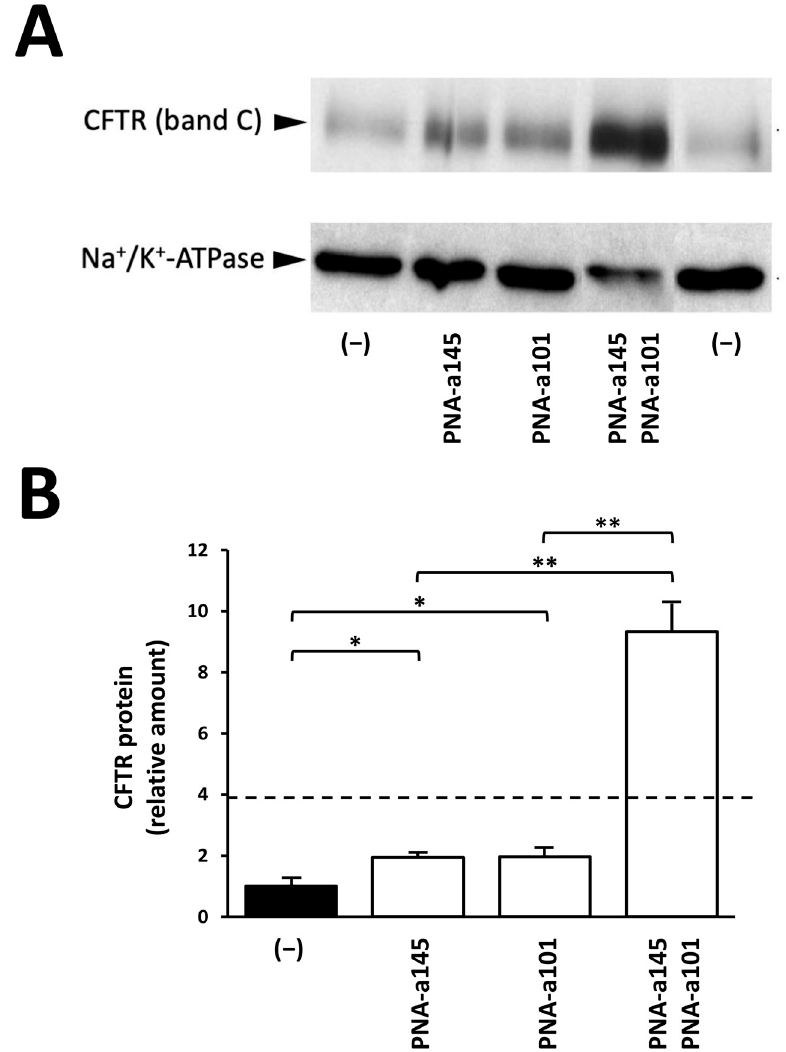
Figure 3. Effects of combined treatment of Calu-3 cells with PNAs against miR-145-5p and miR-101-3p on CFTR protein accumulation. Calu-3 cells were treated for three days with PNA-a145 and PNA-a101, administered either singularly, or in combination. After these treatments, proteins were isolated and Western blotting was performed. ( A ) representative results of Western blotting performed using monoclonal antibodies recognizing CFTR or Na + /K + -ATPase, as indicated; ( B ) summary of the experiments performed. Results represent the mean fold changes with respect to the control untreated cells of the CFTR/Na + /K + -ATPase ratios ( n = 3 independent quantifications of the same blot; * p < 0.05, ** p < 0.01). The uncut version of the Western blotting gels of ( A ) and the relative Ponceau staining are included in Supplementary materials (Figure S1). The dotted line represents the sum of the values obtained with single administrations of PNA-a145 and PNA-a101.